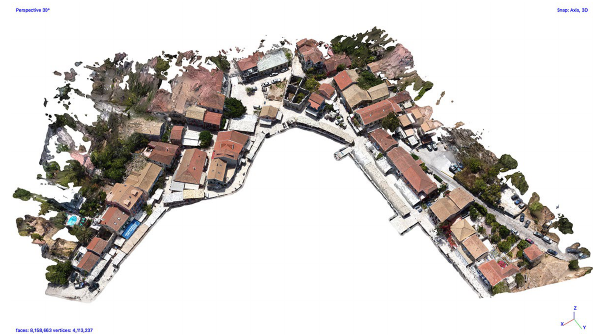
Figure 20 . Fiskardo Port, shaded model.